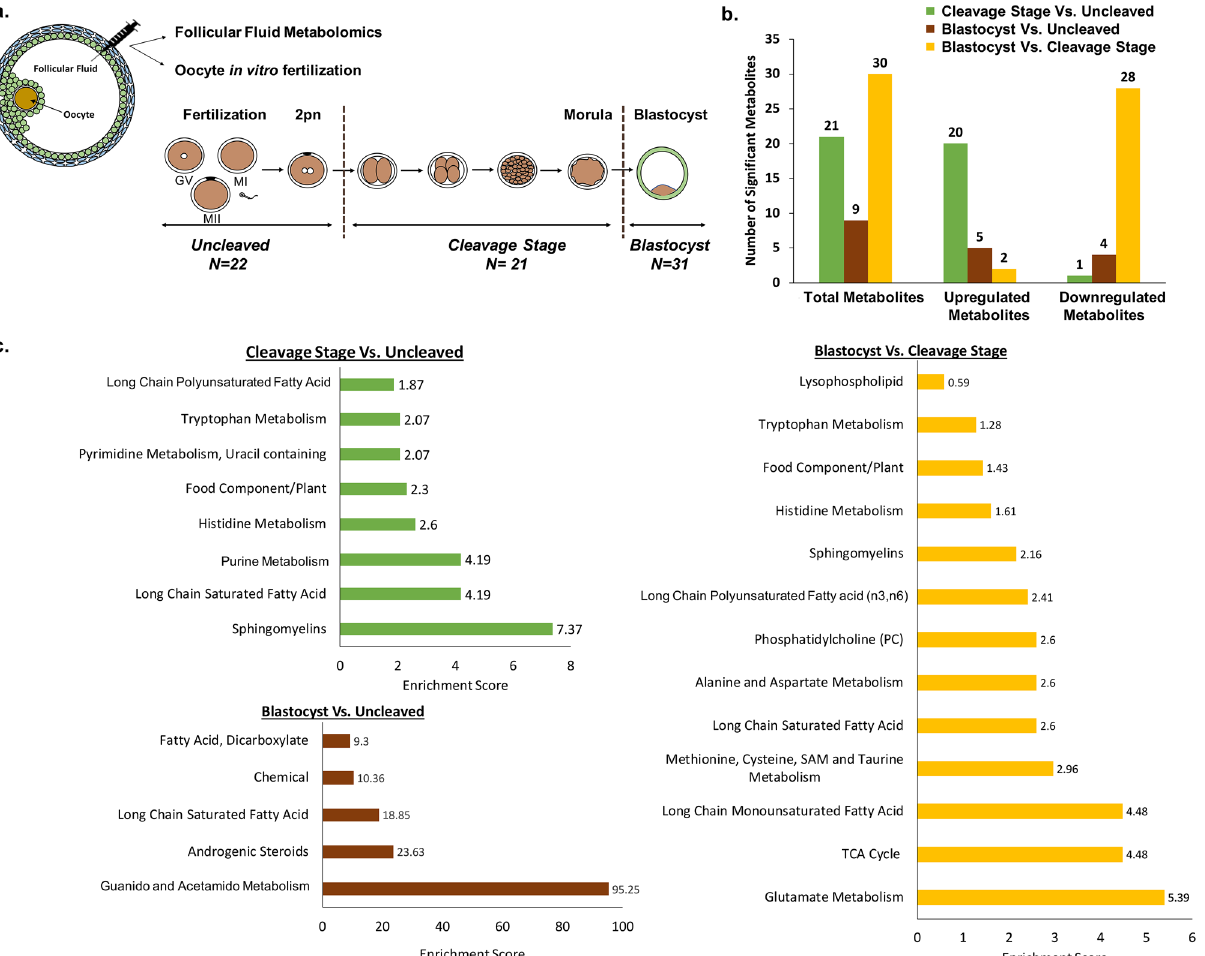
Figure 1. Metabolomics assessment of follicular fluid constituents. ( a ) Schematic depicting the experimental design of the study with the collection of FF for metabolomics analysis and the corresponding oocyte for IVF. Resultant embryos were classified as uncleaved (N = 22), cleavage stage (N = 21), or blastocyst (N = 31). ( b ) The total number of significant metabolites ( p ≤ 0.05) that were upregulated or downregulated in the FF between the embryo groups was determined through pairwise comparisons. Note that the majority of metabolites that were statistically different between the blastocyst and cleavage stage embryo groups were downregulated in blastocysts. ( c ) Pathway enrichment analysis of the metabolites in the FF shown as pairwise comparisons identified multiple fatty acid and metabolism pathways as well as the TCA cycle components that were different between the embryo groups. An enrichment score of greater than 1 indicates that the pathway is enriched in the first group listed compared to the second group and a value of less than 1 indicates that the pathway is enriched in the second group listed versus the first group. Enrichment score = (k/m)/((n-k)/(N-m)) where m = number of metabolites in the pathway, k = number of significant metabolites in the pathway, n = total number of significant metabolites and N = total number of